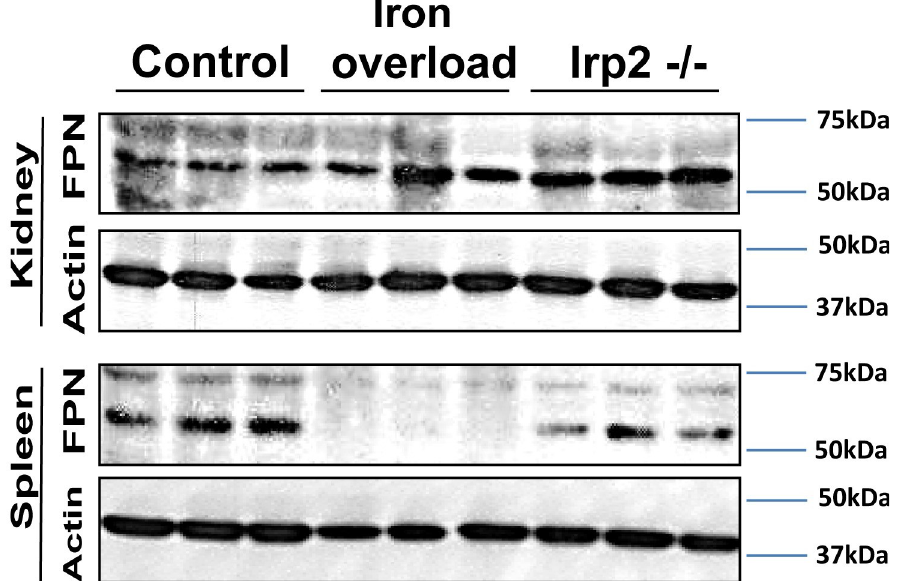
Fig 5. FPN levels are not reduced in kidneys of iron overloaded mice. Spleens and kidneys were lysed in 1% triton buffer and 40 μ g protein was submitted to Western blot analysis following protein separation by 10% SDS-PAGE. Proteins were electro-transferred to a nitrocellulose membrane, which was incubated with antibodies against FPN or actin. FPN was detected as a 60kDa band.